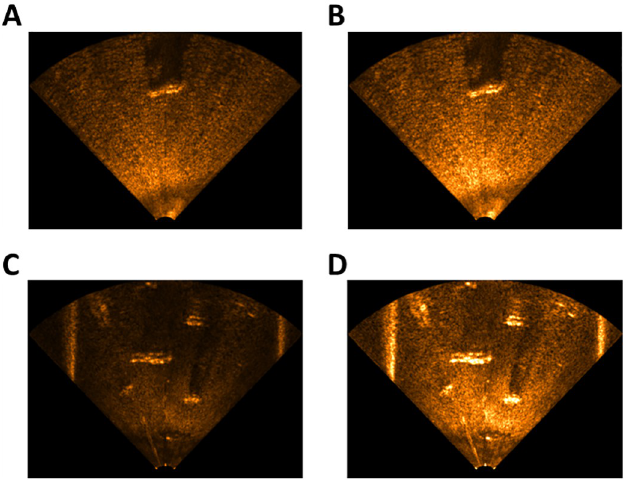
Fig 7. Four datasets created in two environments. (A) Reservoir low sensitivity, (B) Reservoir high sensitivity, (C) Pool low sensitivity, (D) Pool high